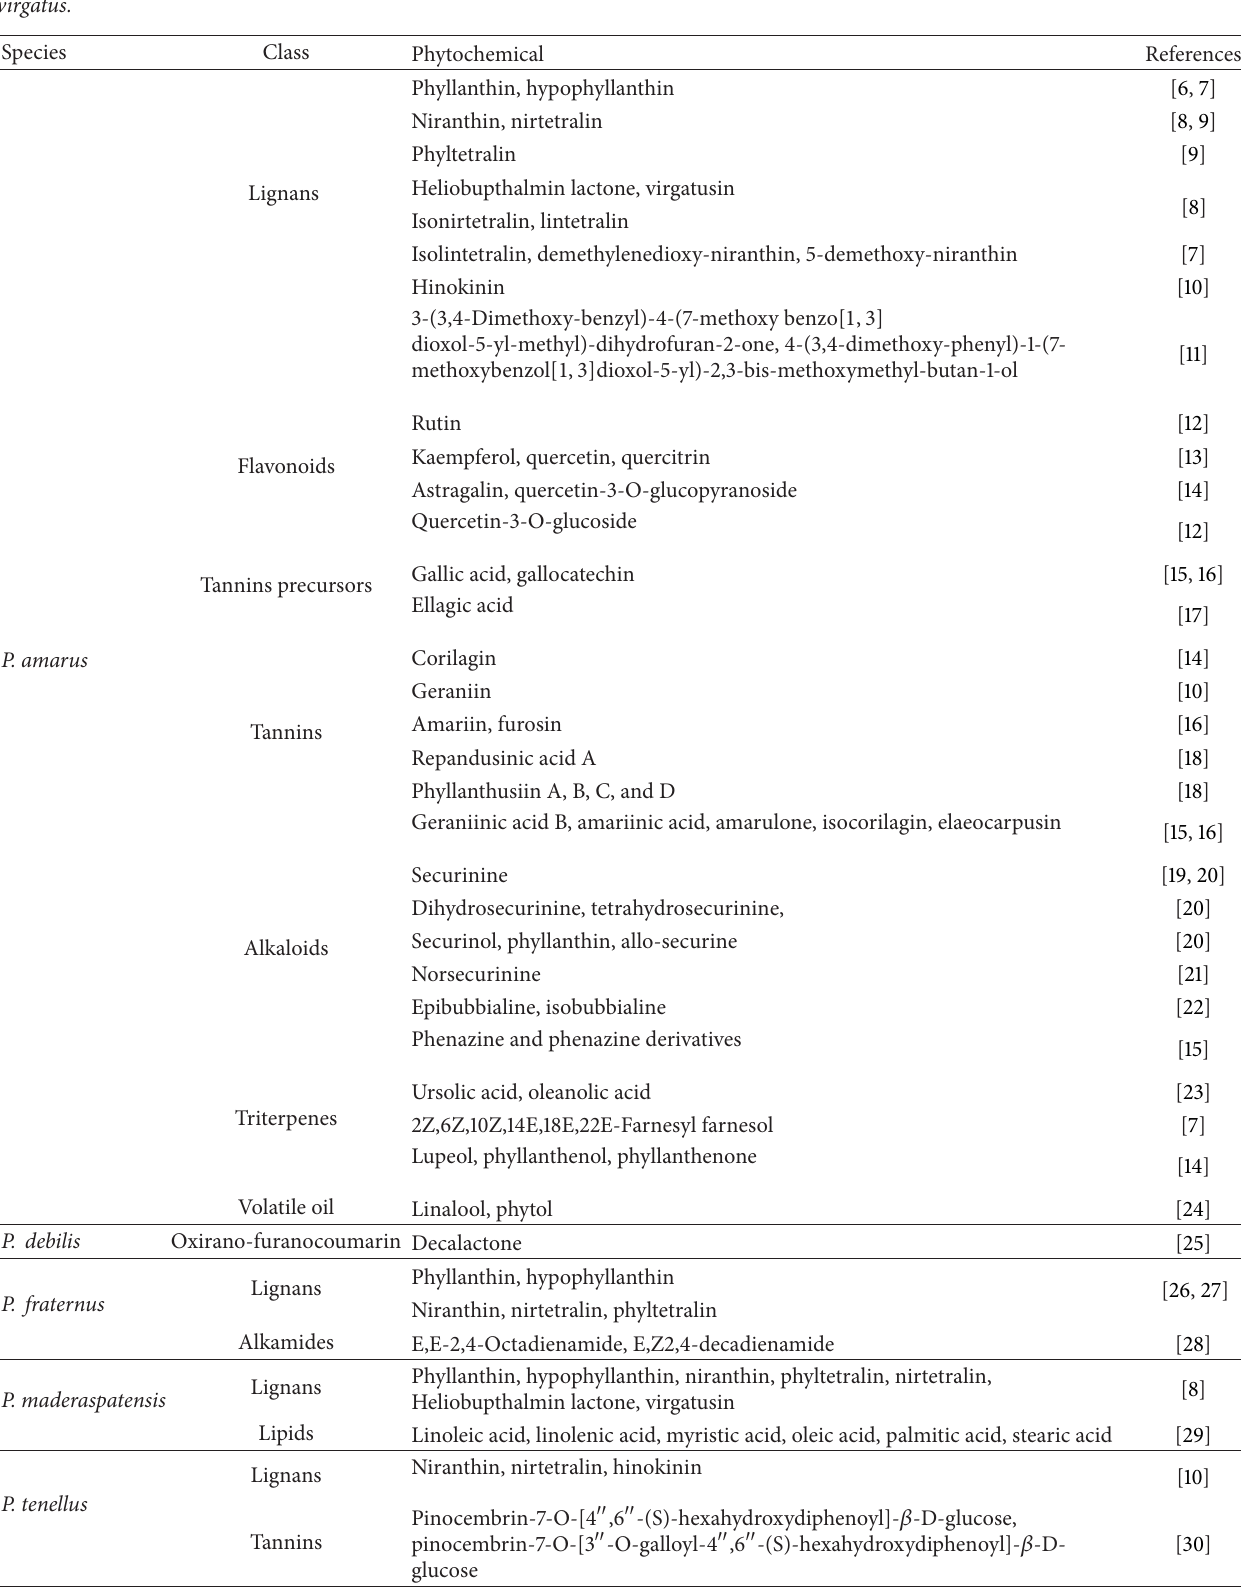
Table 1: Major phytochemicals isolated from Phyllanthus amarus , P. debilis , P. fraternus , P. maderaspatensis , P. tenellus , P. urinaria , and P. virgatus.